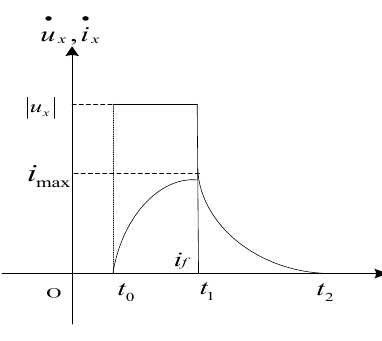
Figure 4. Waveform of voltage and current vectors.